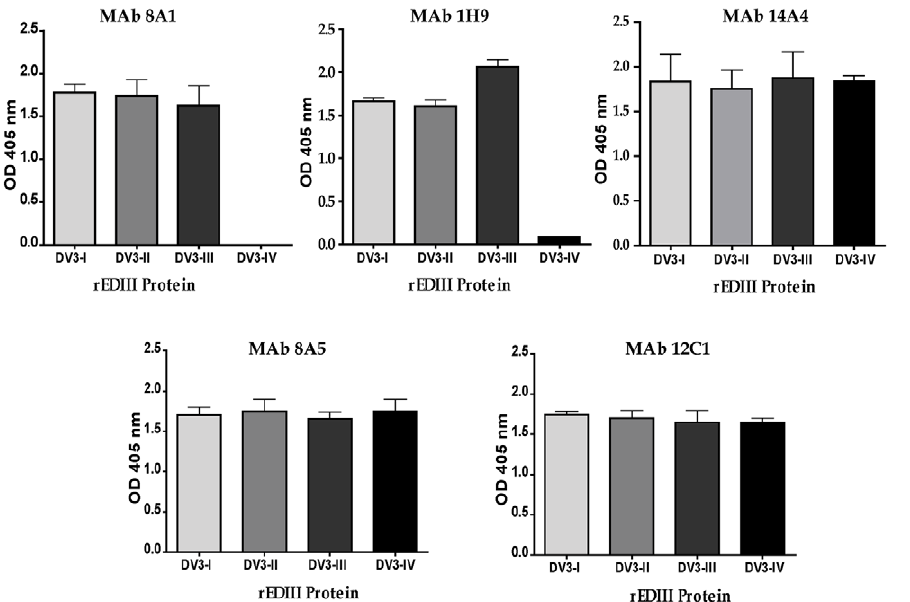
Figure 5. Binding of mouse MAbs to recombinant EDIII from the 4 genotypes of DENV3. MAb binding was detected by ELISA. MAbs 8A1 and 1H9 bound to EDIII from DENV3 genotypes I, II and III but not to IV. MAbs 14A4, 8A5 and 12C1 bound to all 4 genotypes.